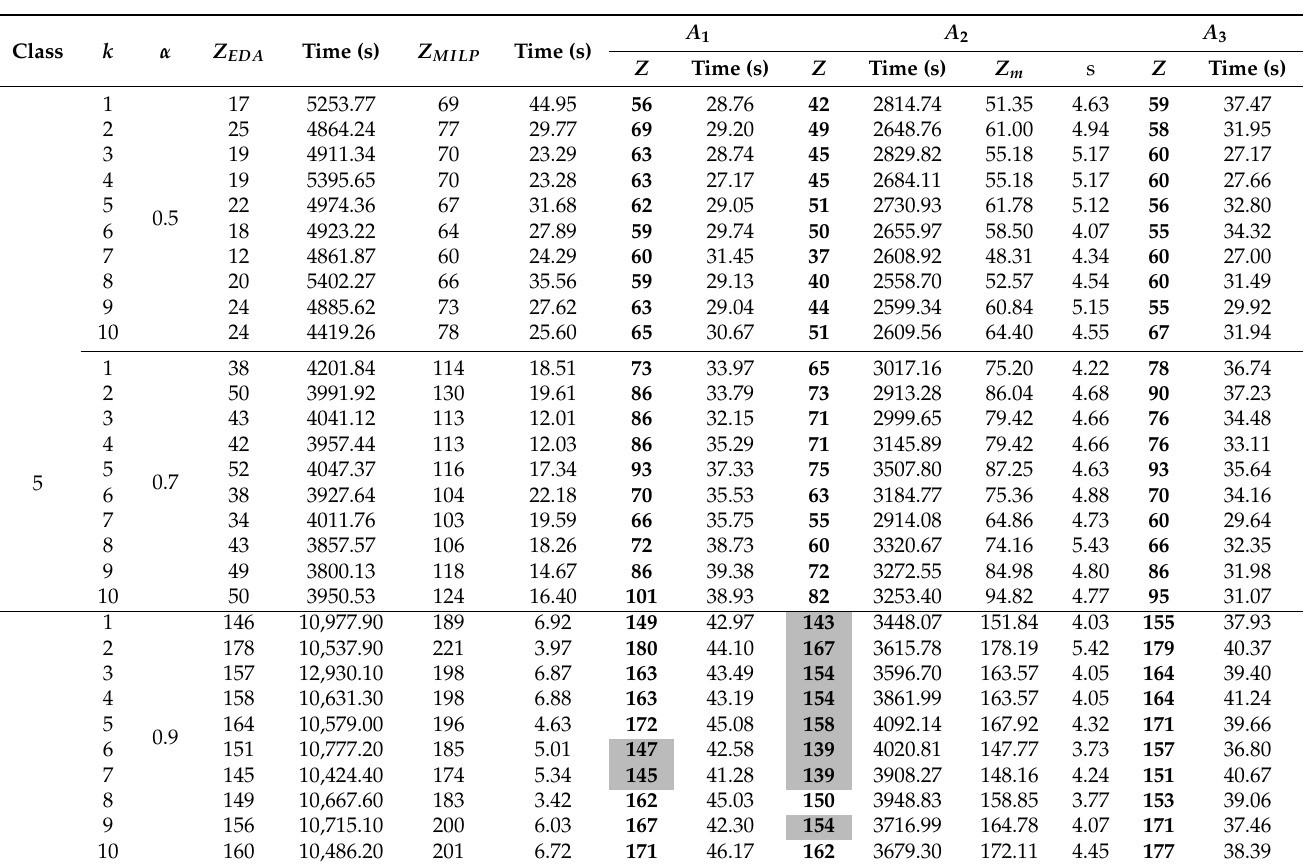
Table 5. Results for Class 5